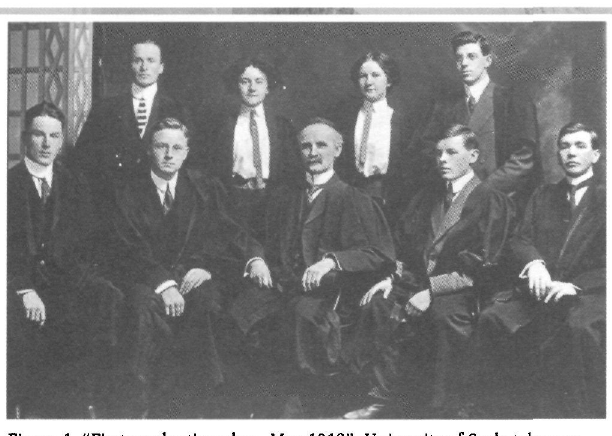
Figure 1. "First graduating class, May 1912", University of Saskatchewan. Courtesy of University of Saskatchewan Archives